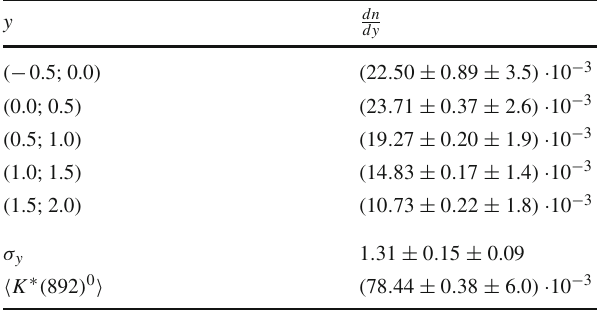
Table 5 Numerical values of the p T -integrated and extrapolated dn distributionpresentedinFig.12.Thefirstuncertaintyisstatistical,while the second one is systematic. Additionally, the width of the Gaussian fit to the dn distribution, as well as the mean multiplicity of K ∗ ( 892 ) 0 dy mesons are shown (see the text for